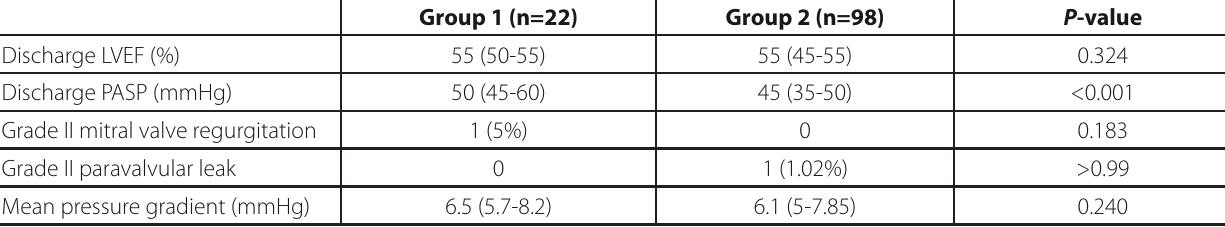
Table 3. Comparison of pre-discharge echocardiographic